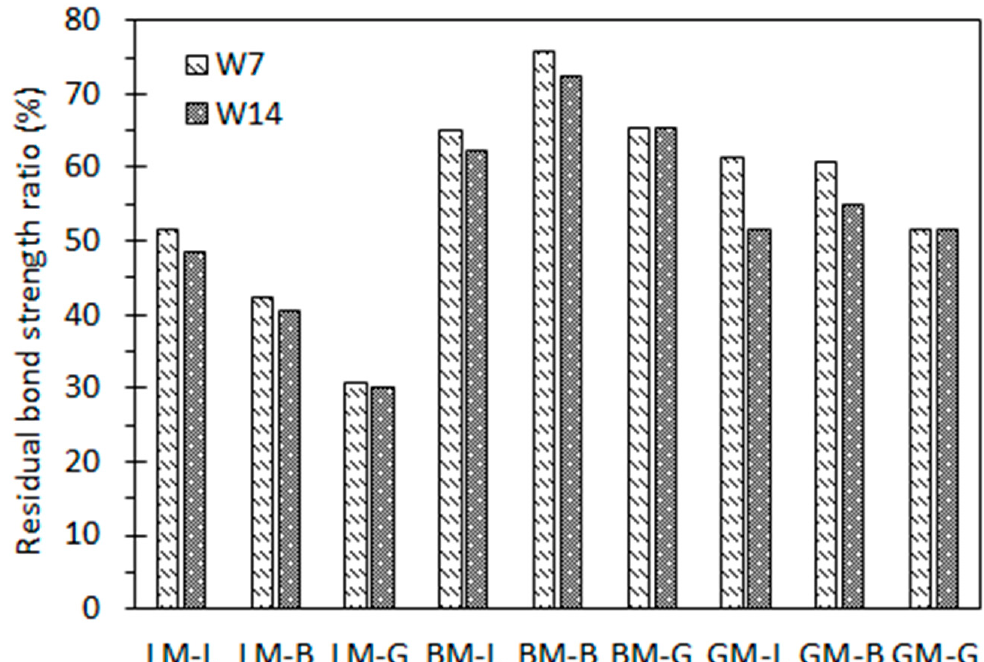
Figure 12. Residual bond strength ratios of asphalt mortar–aggregate interfaces under 7-day and 14-day water immersion.